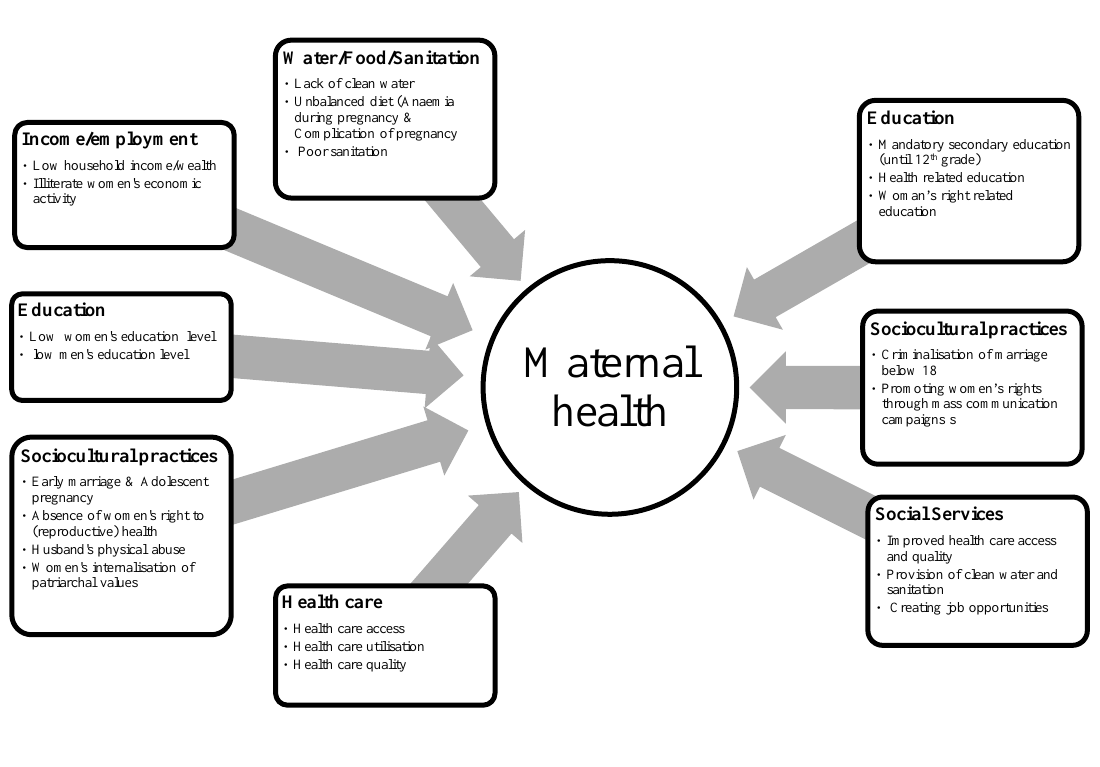
Figure 3. Factors negatively (left side) and positively (right side) influencing maternal health in Afghanistan with health care utilization, lower fertility rate, family planning, and improved maternal health. In general, better education decreases unhealthy social practices such as early childhood marriage and adolescent